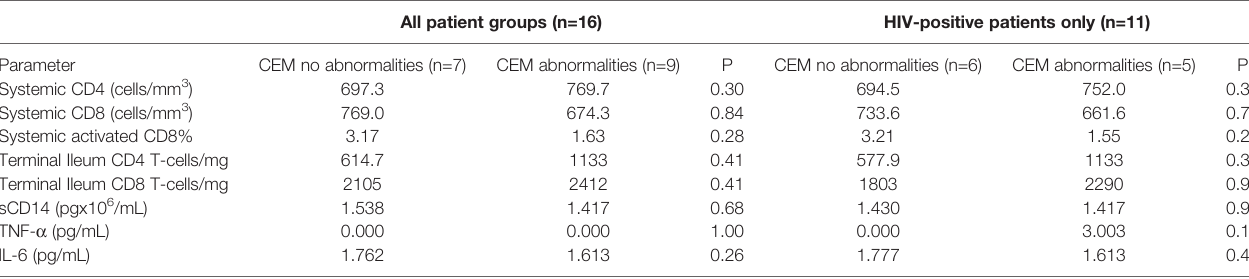
TABLE 4 | Relationship of confocal endomicroscopy features identi fi ed in patients and measured